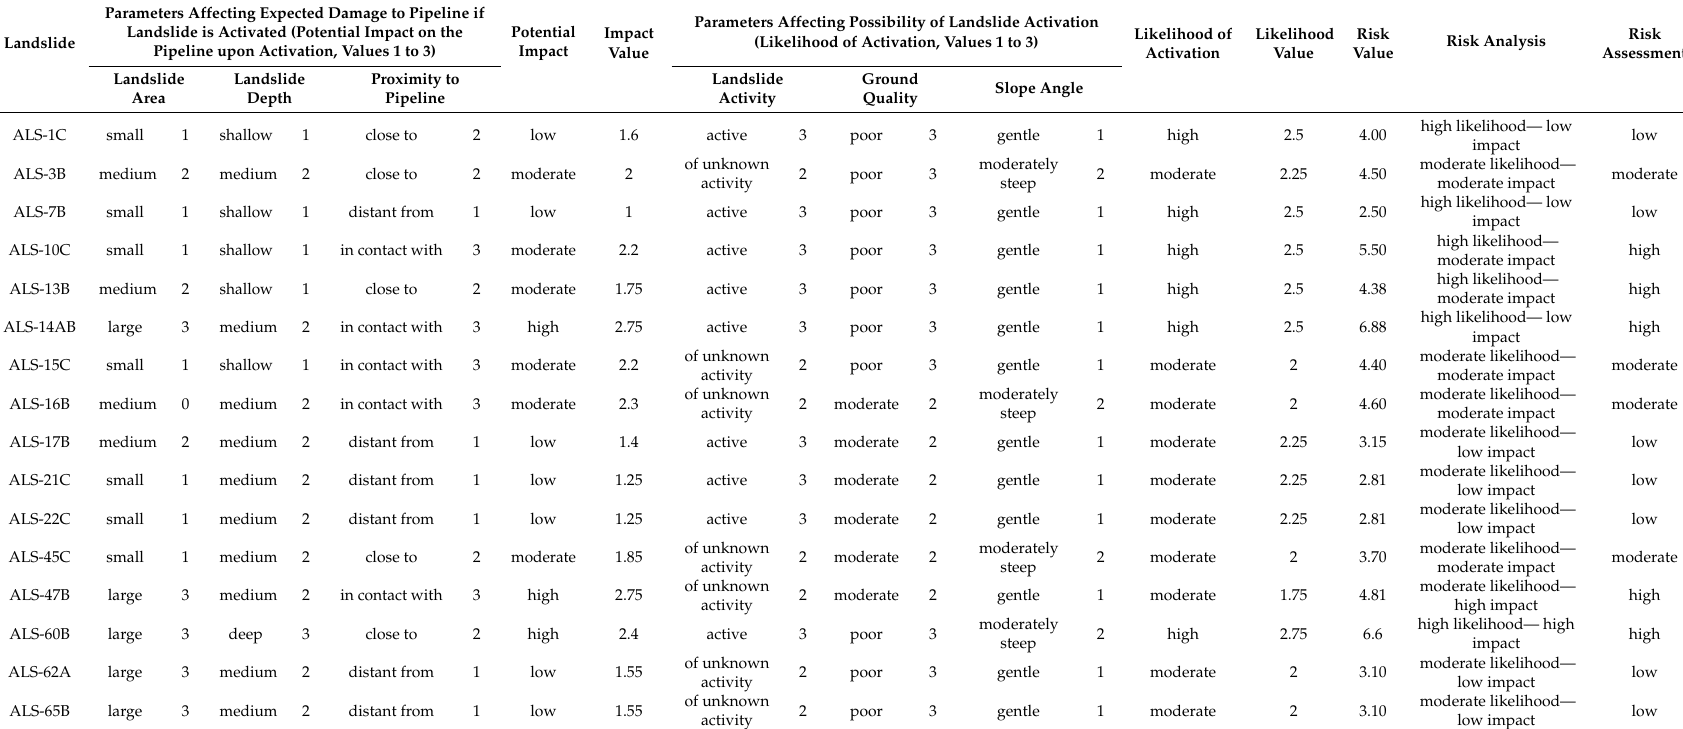
Table 5. Indicative landslide risk assessment for some of the 82 identified landslides (see Figures 12, 13, 17 and